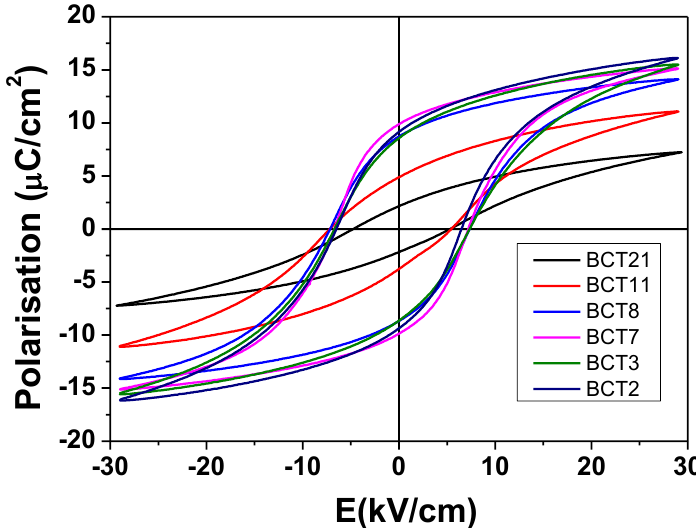
€ hysteresis loops for Ba 0.90 Ca 0.10 TiO 3 ceramics.